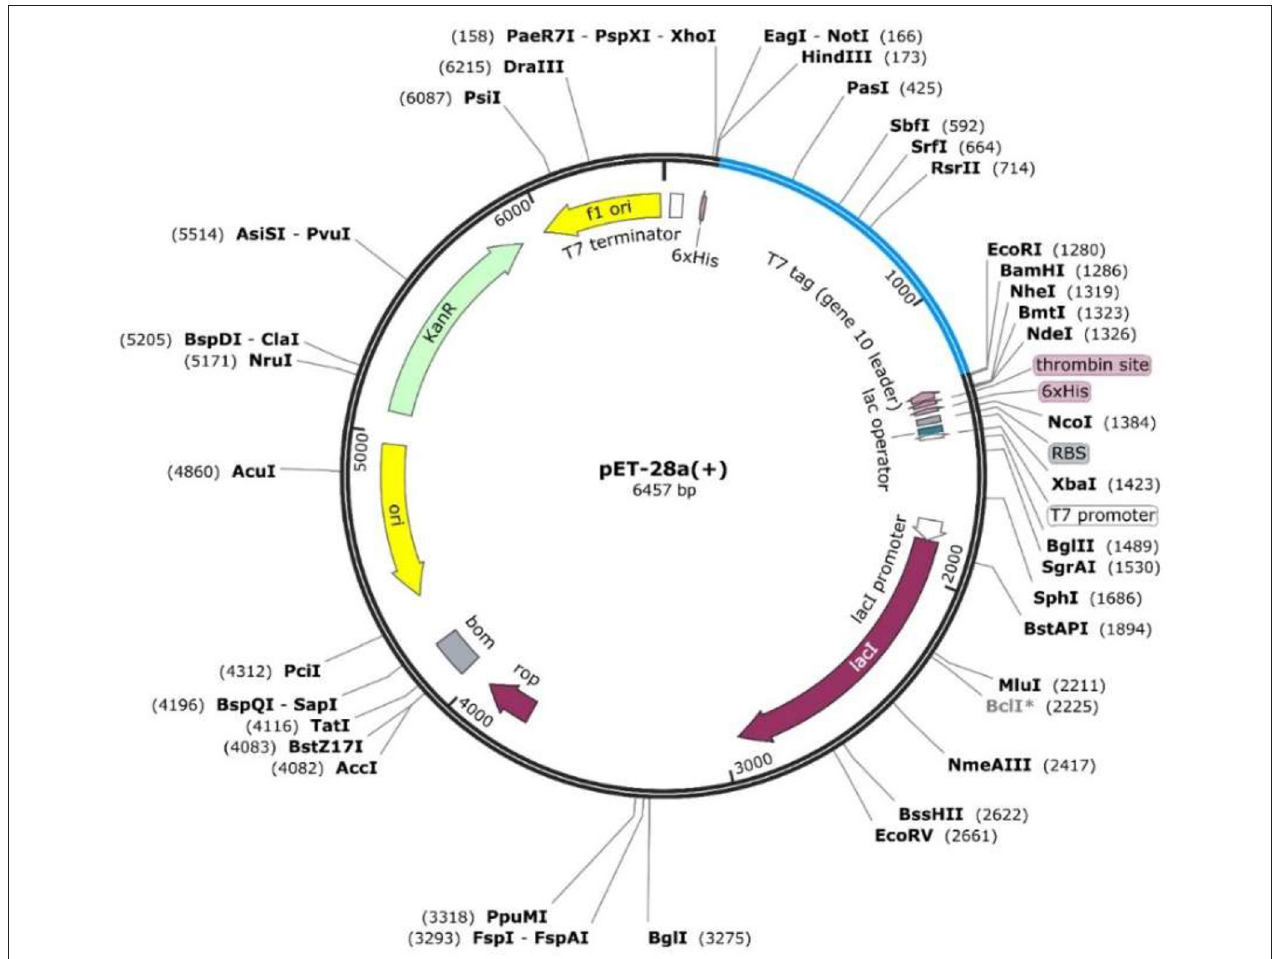
FIGURE 5 | The designed plasmid map for the proposed vaccine construct by using restriction enzymes (XhoI and ECOR1) in the pet28a ( + )